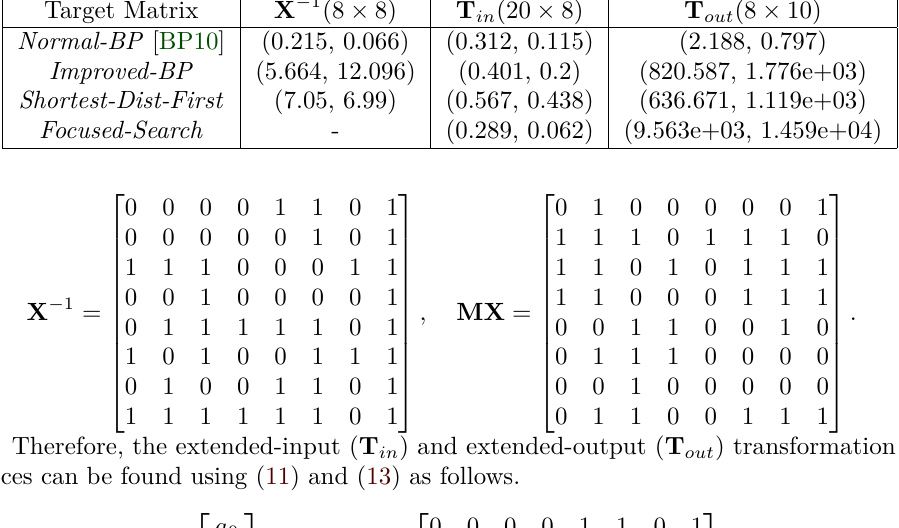
Table 2: The mean and standard deviation of computation time (in seconds) for the Normal-BP [BP10] against the three proposed logic-minimization